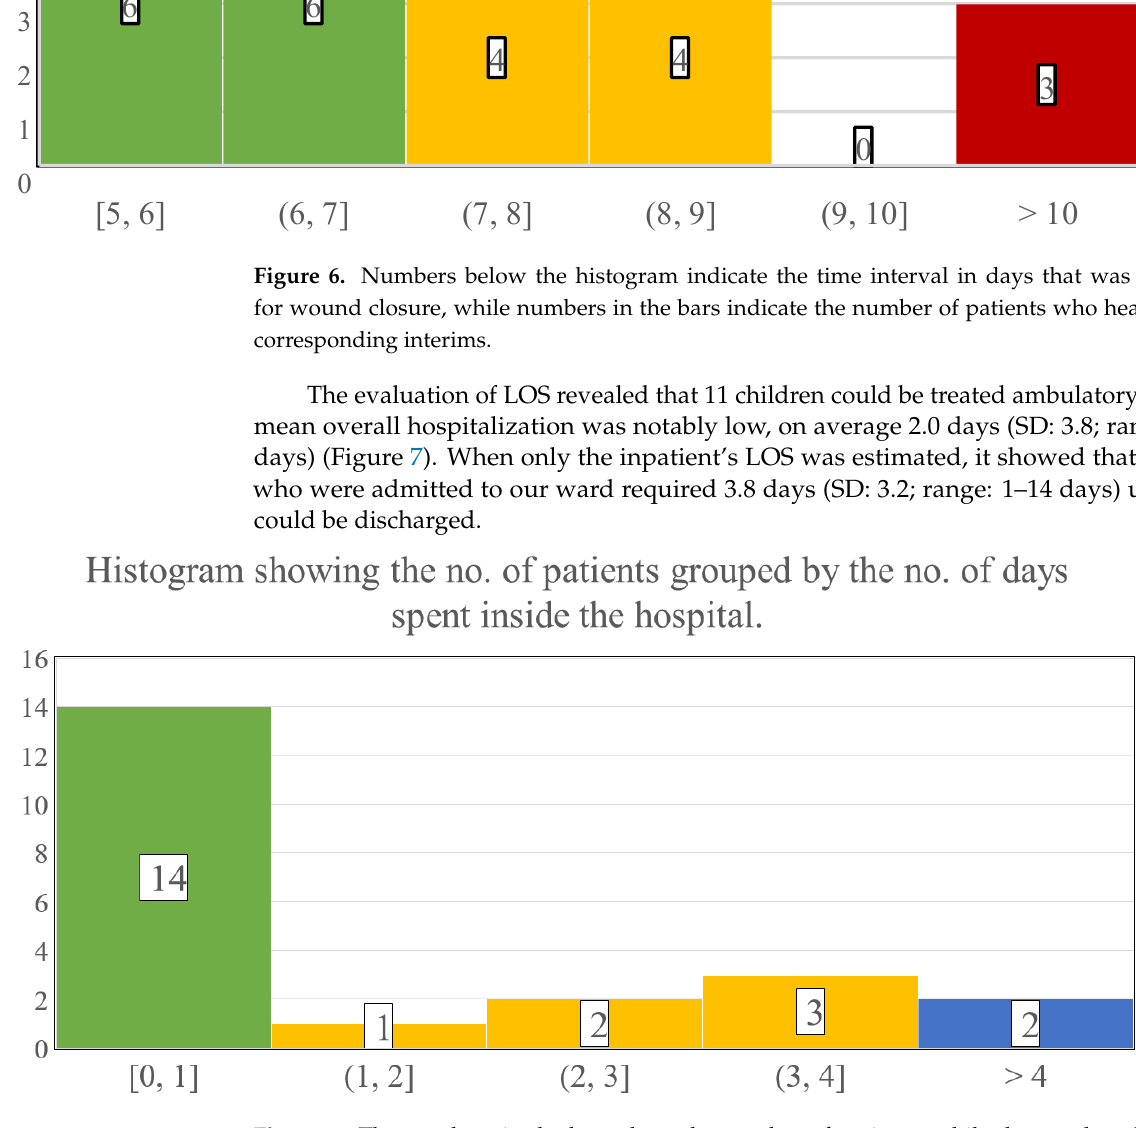
Figure 7. The numbers in the bars show the number of patients, while the numbers below the histogram indicate the time intervals in days spent hospitalized.